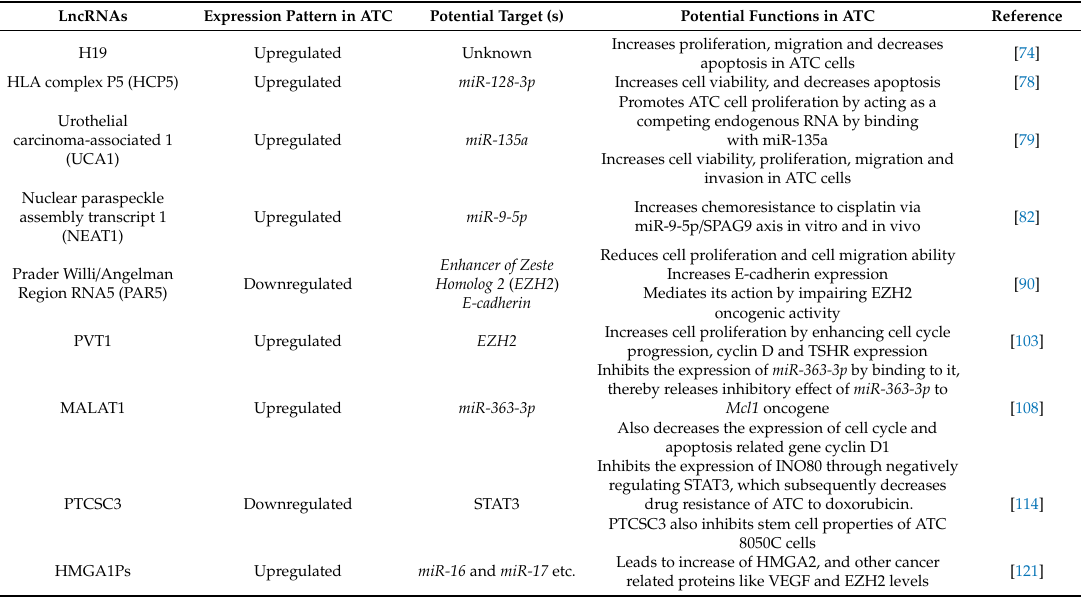
Table 2. Implications of lncRNAs in anaplastic thyroid carcinoma